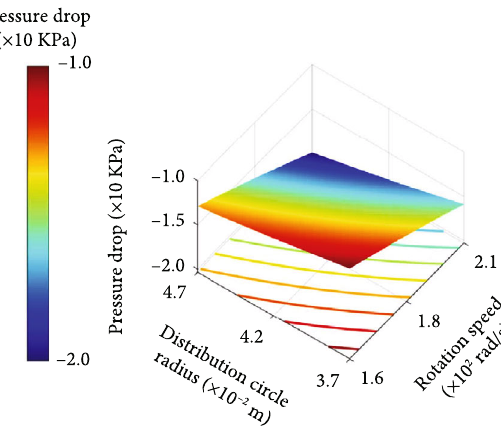
Figure 2: The relationship between the distribution circle radius R , the rotation speed w , and the variable pressure drop term c